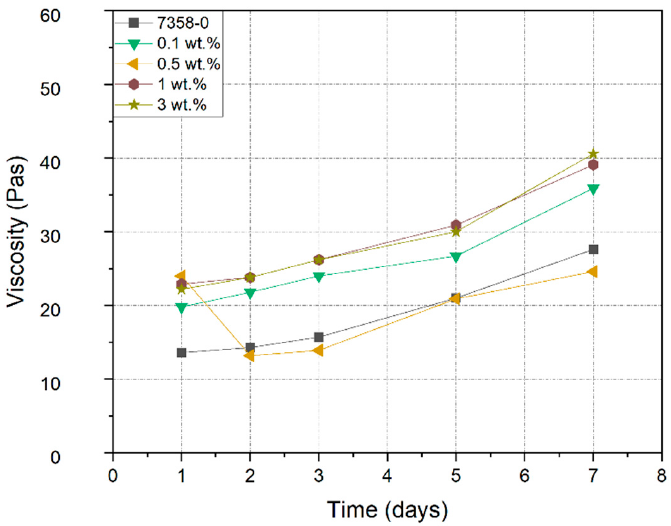
Figure 4. Influence of palygorskite addition on Si-PSA composition viscosity.